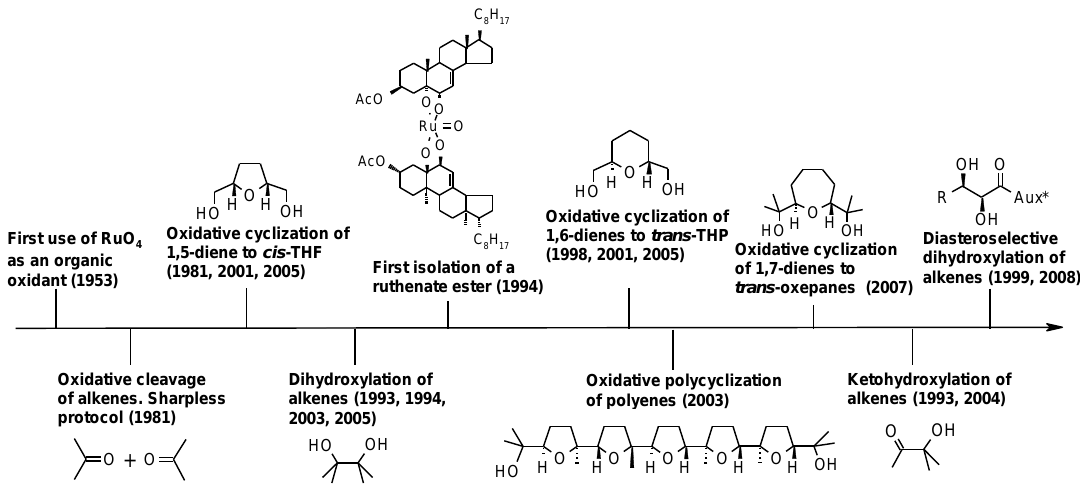
Figure 1. Chronological development of the oxidative transformations of alkenes, dienes and polyenes catalysed by RuO . Significant dates are shown in 4